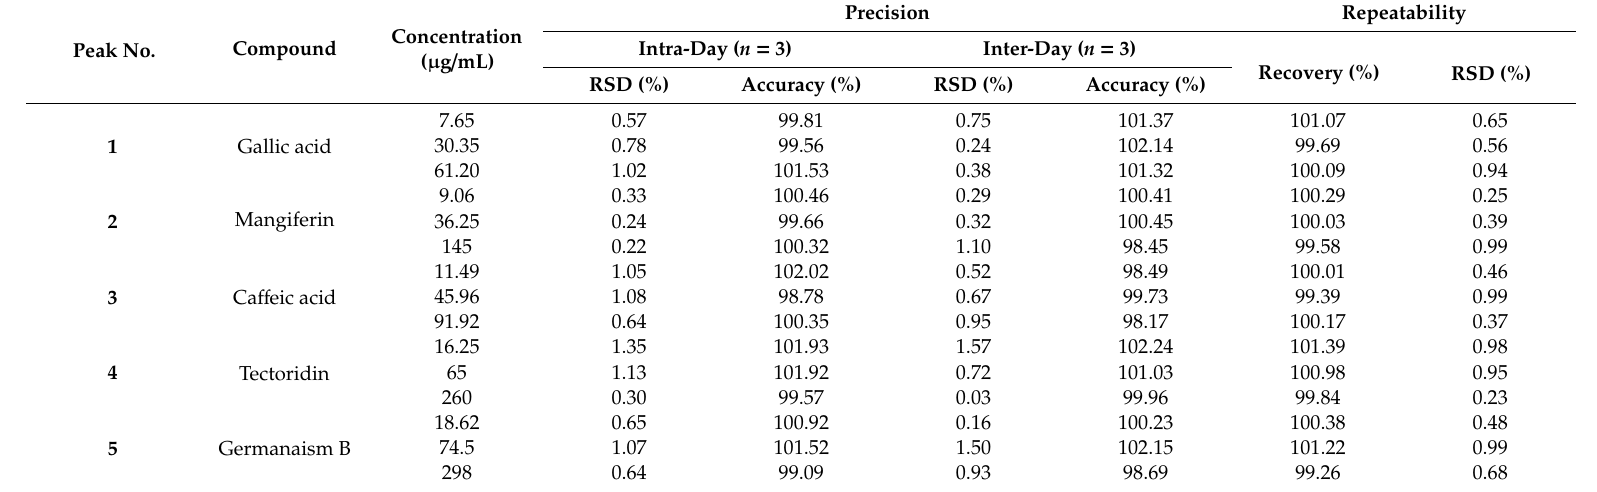
Table 2. Precision and stability of the eleven quantified